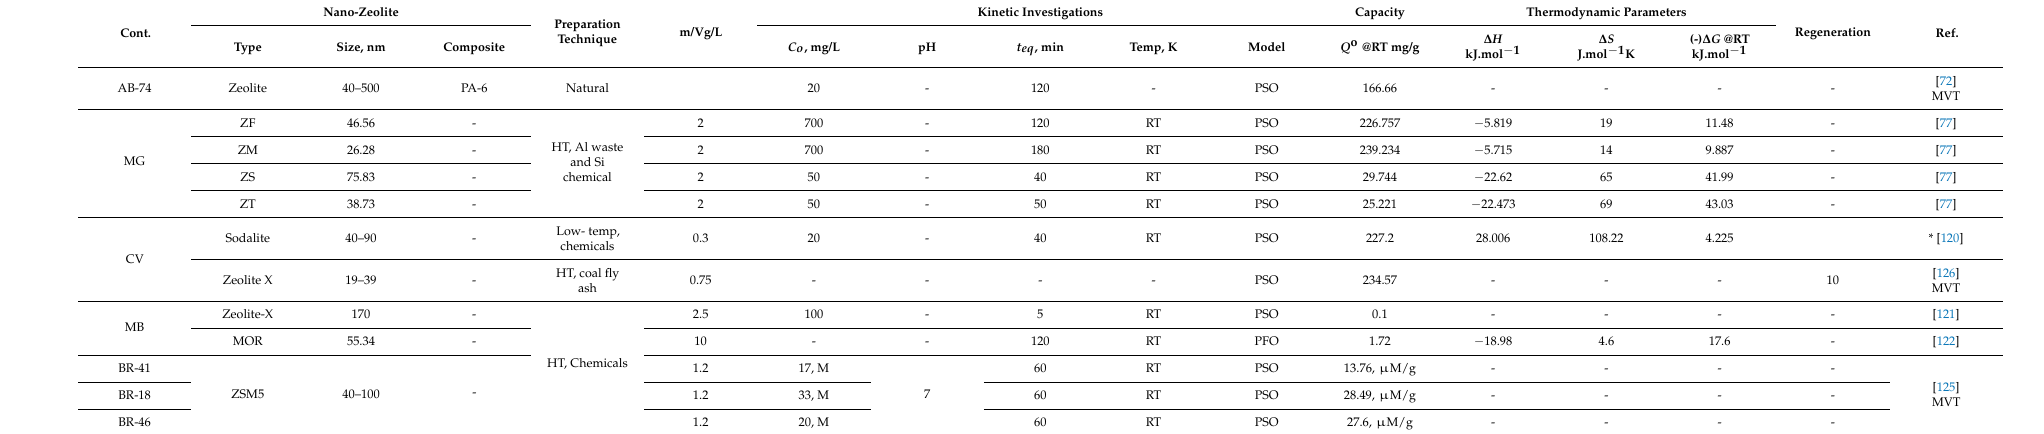
Table 6. Applications of Nano-zeolites in dye